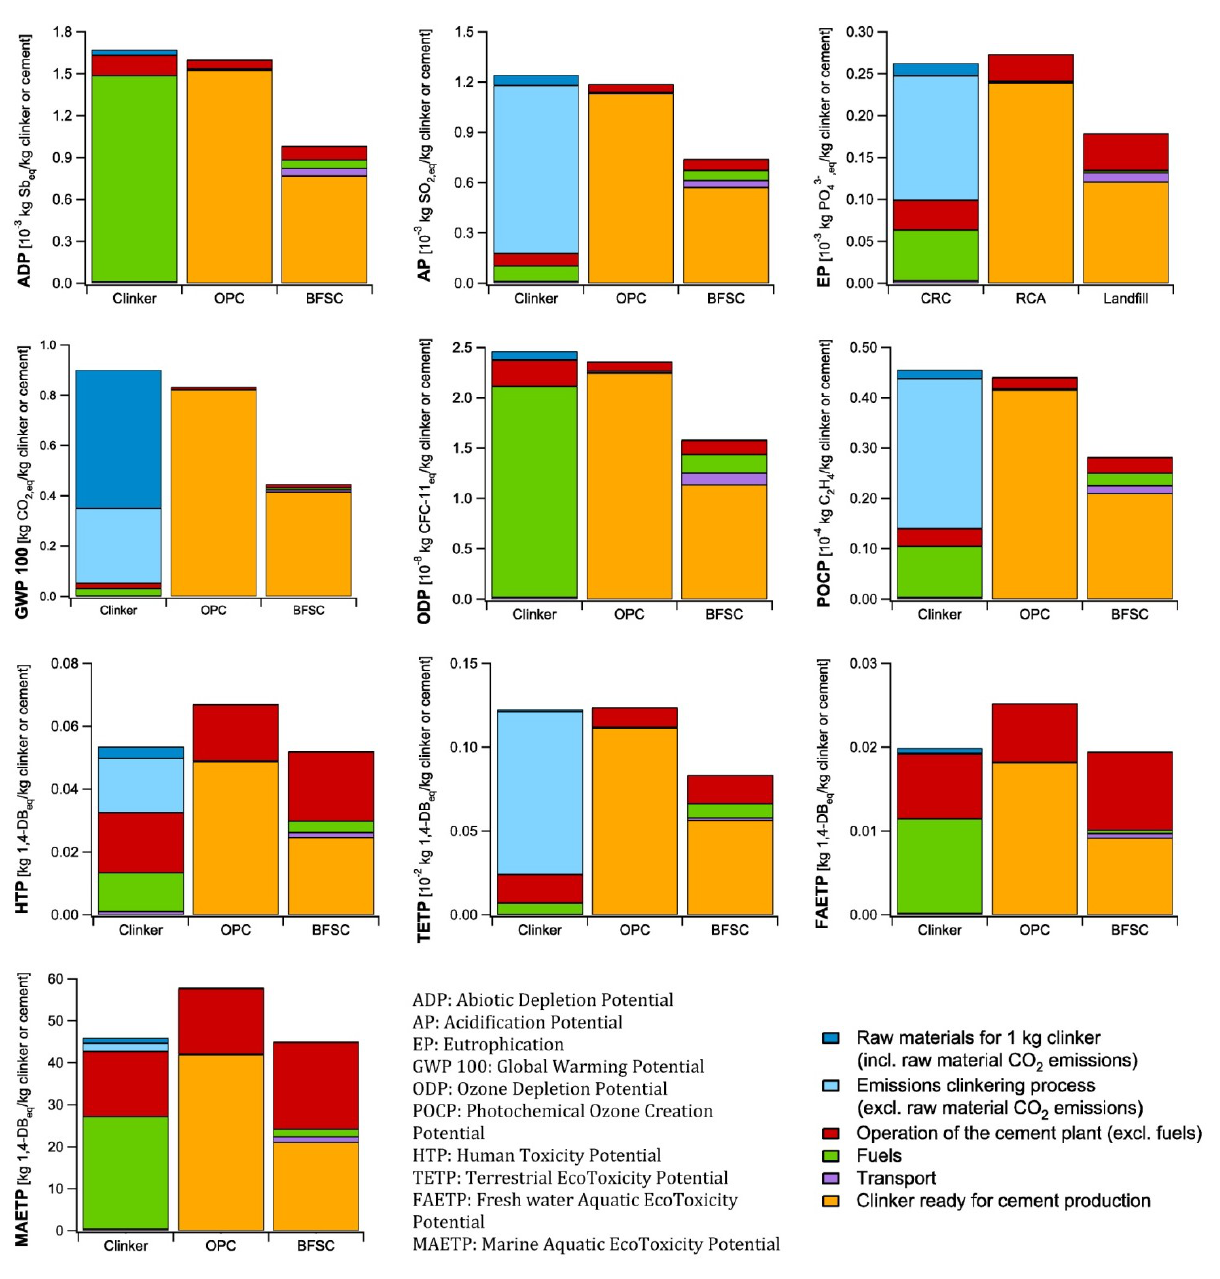
Figure 2. Life Cycle Impact Assessment of 1 kg clinker or